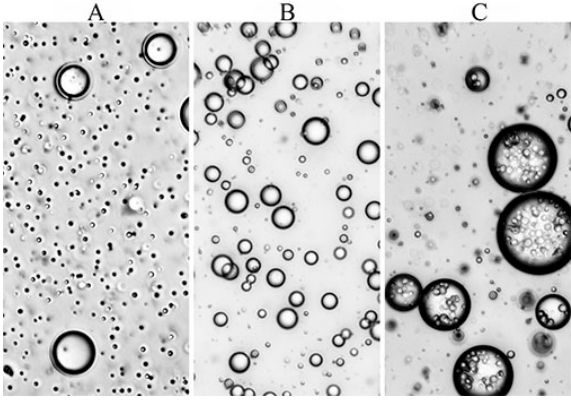
Figure 5. The morphology of a 20% PAN solution containing 5% HMDSO ( A ), PDMS-400 ( B ), or SKTN-E ( C ). SKTN-E ( C